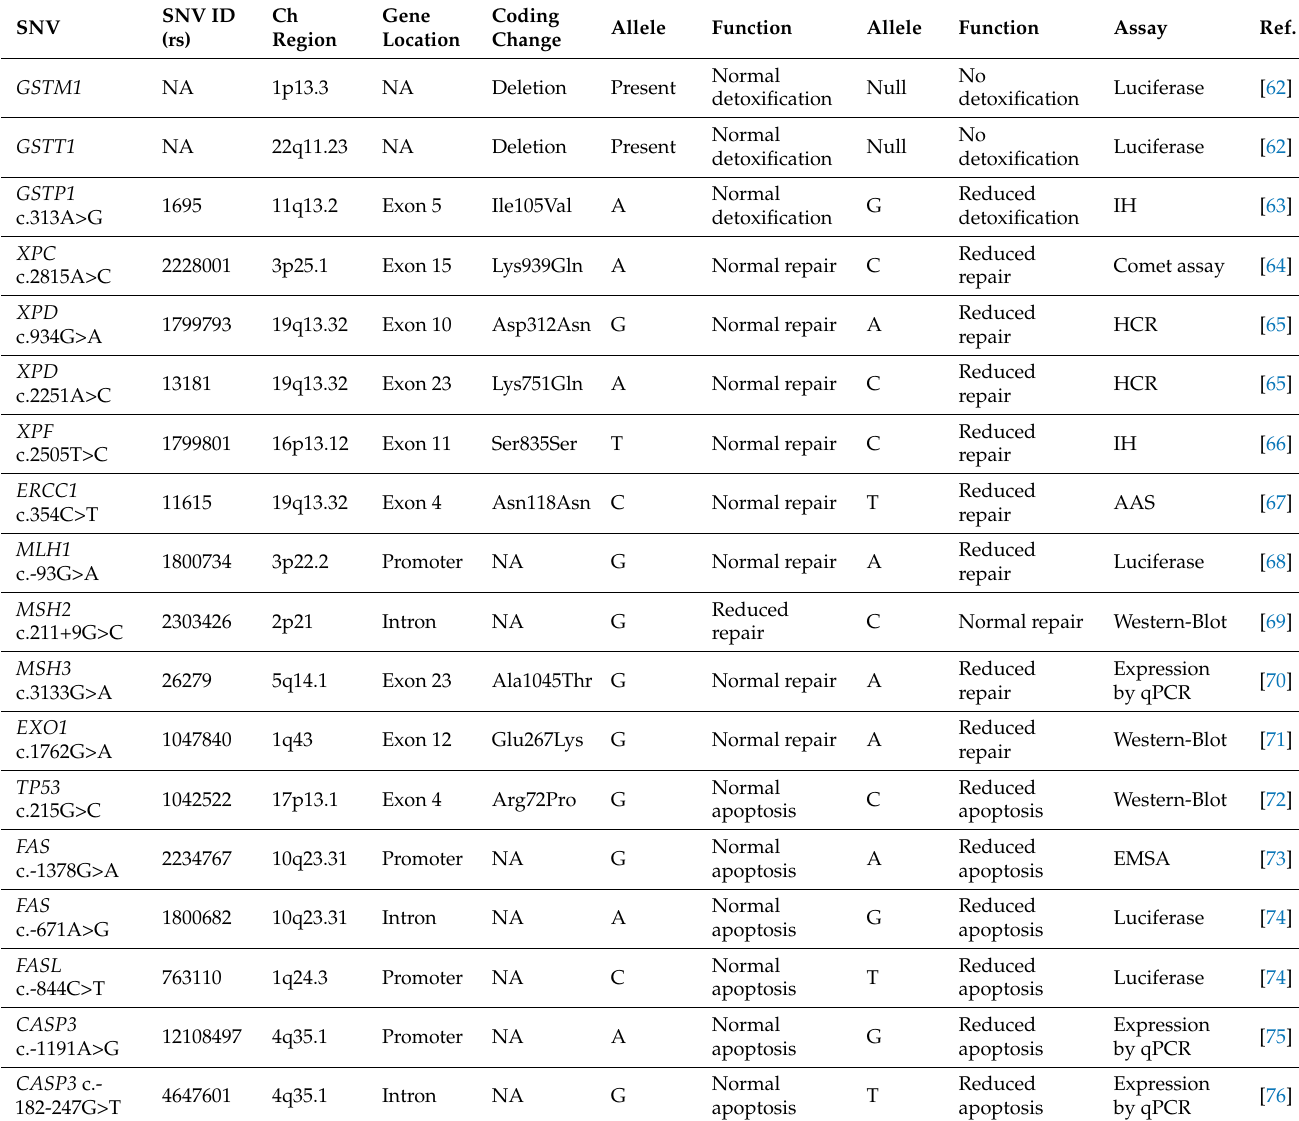
Table A1. Summary of evidence on single nucleotide variants encoding cisplatin metabolism and their expected